Question: Draft a figure caption describing what is shown.
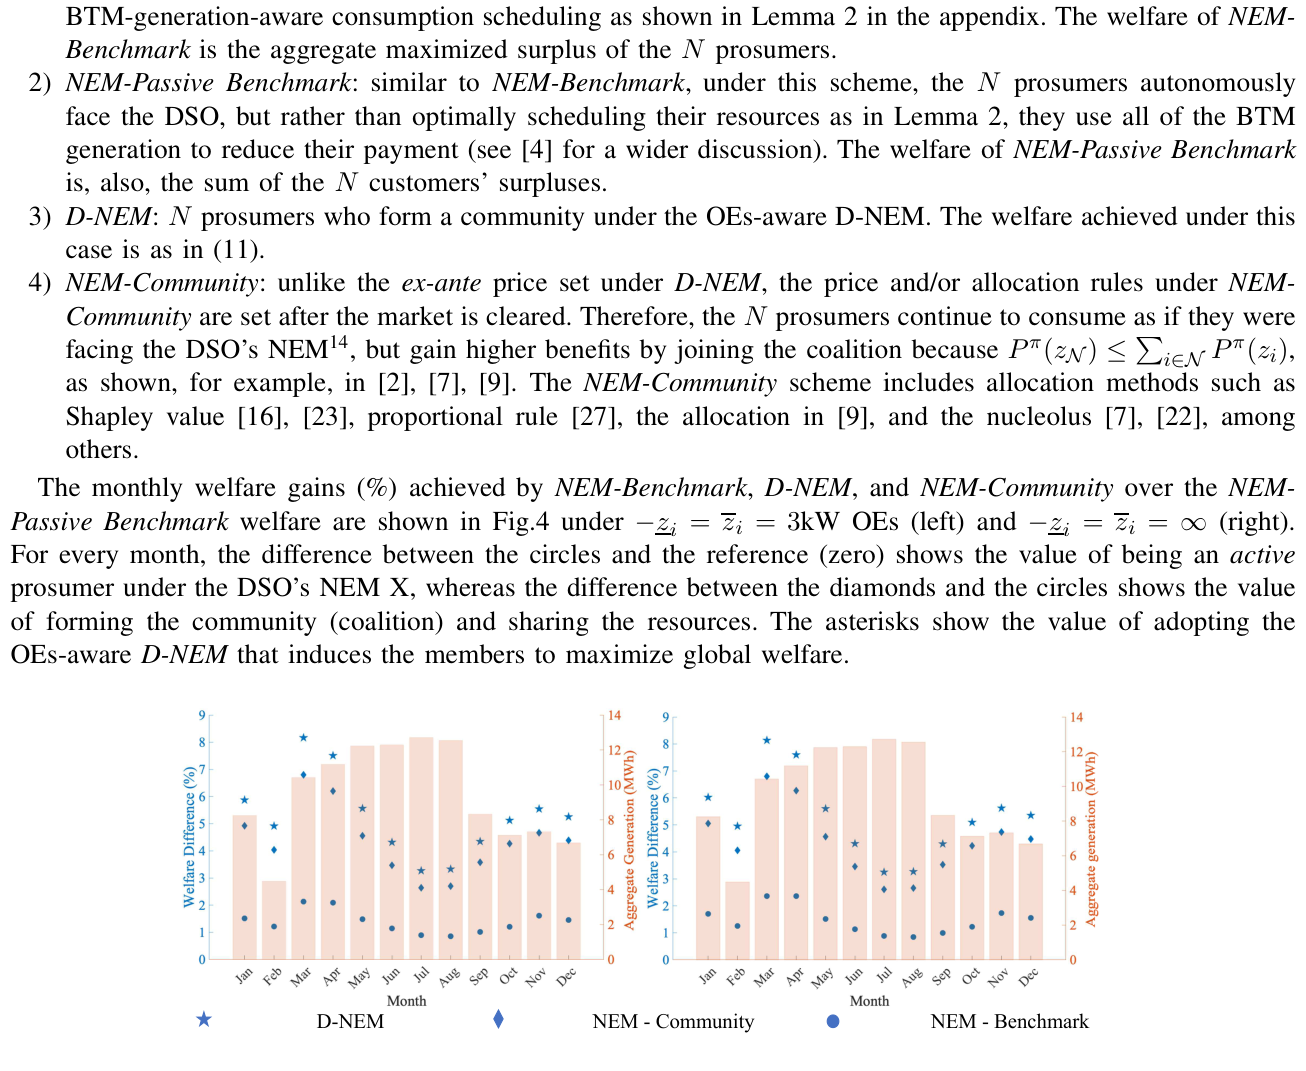
Answer: Monthly welfare gain (%) over NEM - Passive Benchmark under −zi = zi = 3kW (left) and −zi = zi = ∞(right). The bar chart shows the aggregate community generation bN .